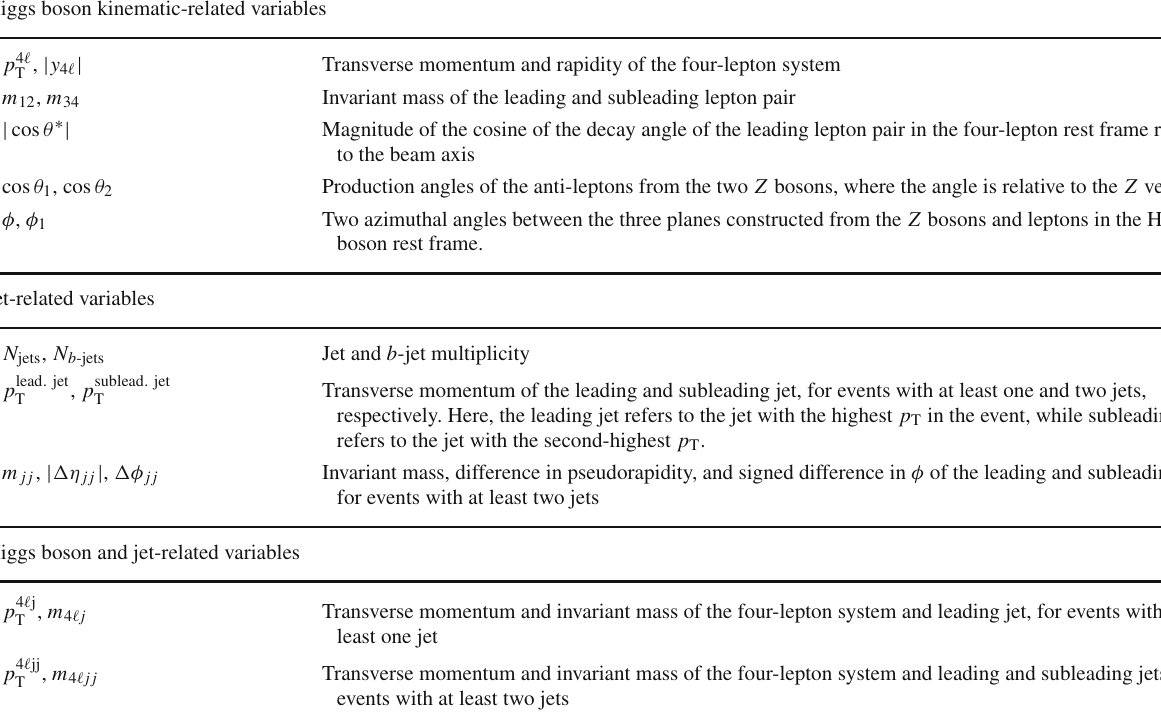
Table 4 Definitions of observables for which differential cross sec- tions are measured. The angular variables are defined as in Ref. [132]. In addition to the single observables listed, the following double differ- ential observables are built using variables defined below: m 12 vs. m 34 , . jet p 4 (cid:3) vs. N jets , p 4 (cid:3) vs. p lead T T